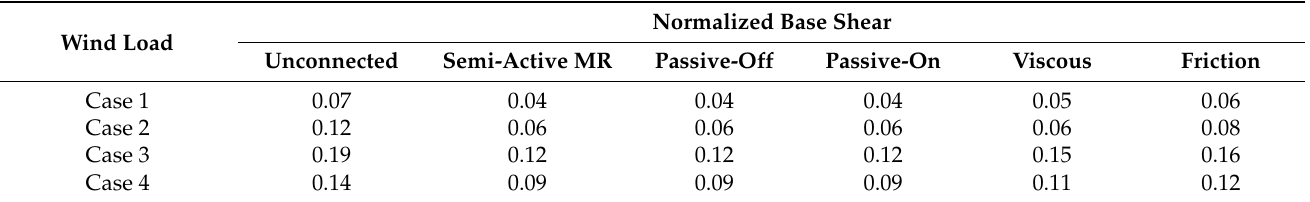
Table 15. Comparison of peak normalized base shear of the coupled flexible building under different control strategies when dampers are arranged in Configuration